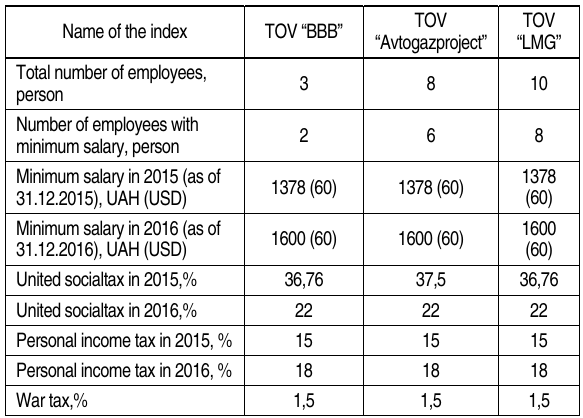
Table 1. Incoming information about labour remunera- tion and social tax payments made by business organi- zations TOV “BBB”, TOV “Avtogazproject”, TOV